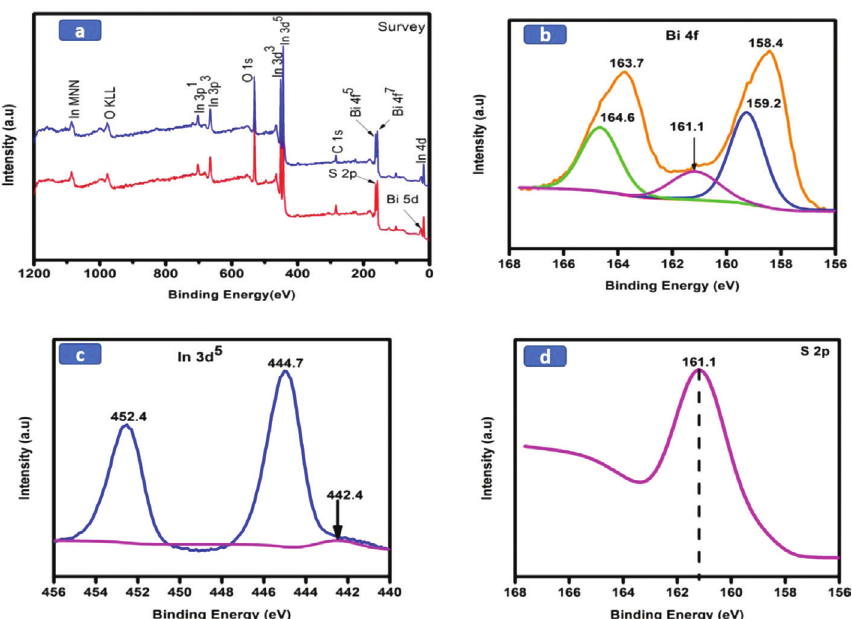
-In S -Bi S thin films developed from precursors (1) and (2) using toluene and chloroform as solvents at 3 2 3 2 3